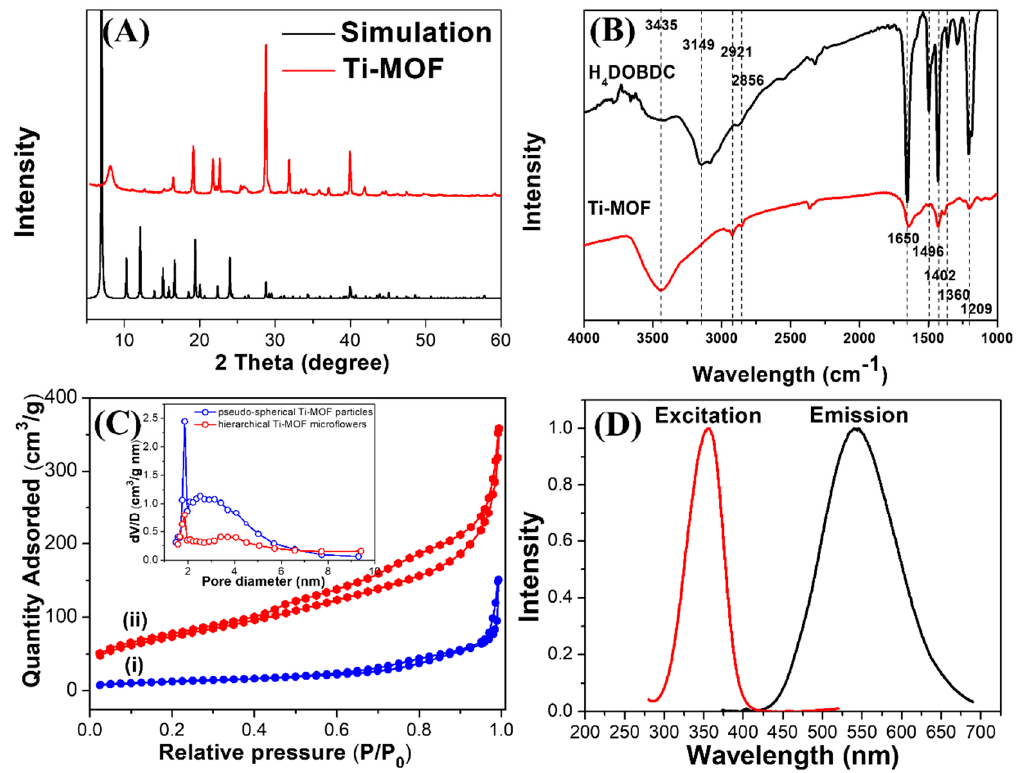
Figure 2. ( A ) Simulated and experimental powder XRD patterns for Ti-MOF microflowers. ( B ) FT-IR spectra of H 4 DOBDC and Ti-MOF microflowers. ( C ) N 2 adsorption-desorption isotherms and the pore size distribution (inset image) of (i) pseudo-spherical Ti-MOF particles and (ii) hierarchical Ti-MOF microflowers. ( D ) Fluorescence excitation (red line) and emission (blue line) spectra of Ti-MOF microflowers.